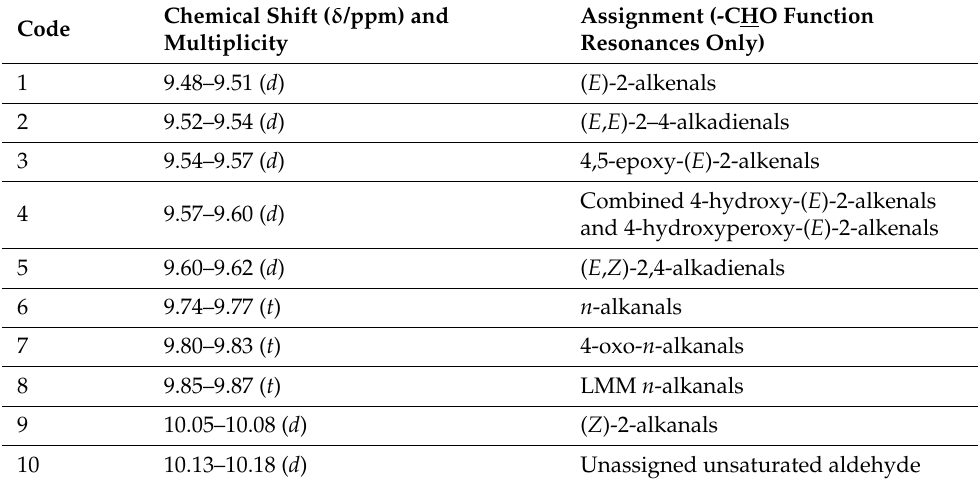
Table 3. Chemical shift values, multiplicities and assignments of aldehyde-CHO function resonances in 1 H NMR spectra acquired on thermally stressed culinary oils at an operating frequency of 600 MHz. Abbreviations: d , doublet; t ,